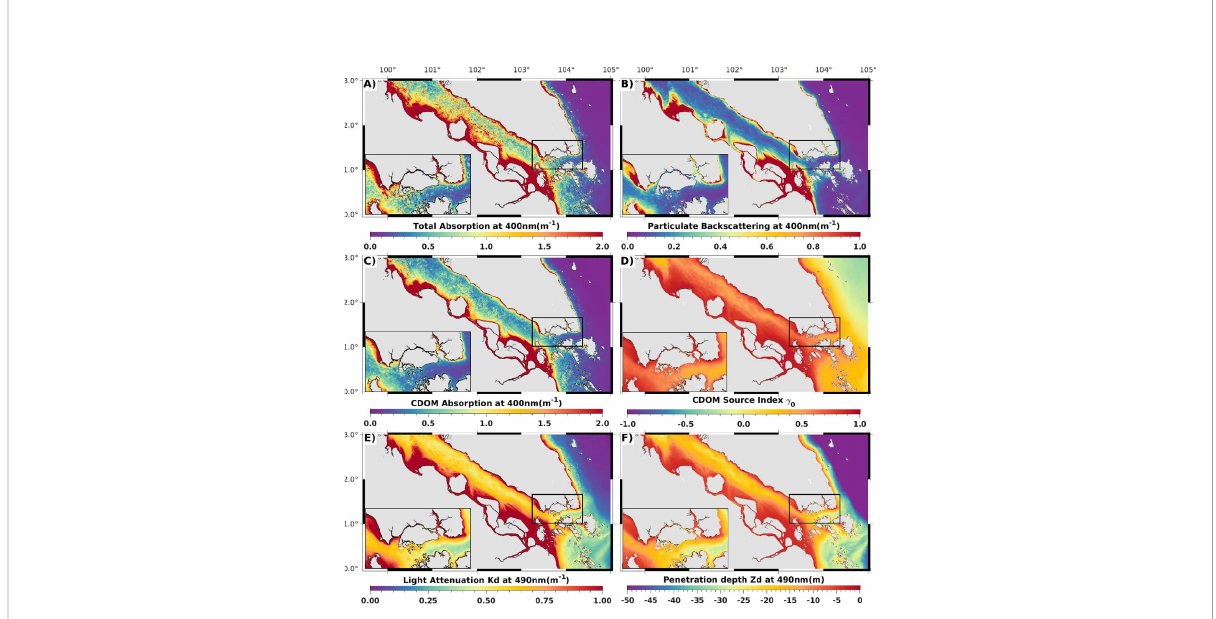
FIGURE 4 Spatial distribution of the 2017 – 2020 mean values of blended QAA derived optical properties (A) Total absorption coef fi cient of light (a t ) at 400 nm. (B) Particulate backscattering (b bp ) at 400nm. (C) CDOM absorption coef fi cient (a g ) at 400 nm. (D) CDOM source index, g 0 (values ≥ 0.5 indicate the increasing dominance of terrigenous origin of CDOM over marine) (E) Diffuse attenuation coef fi cient of light (K d ) at 490 nm. (F) Depth of penetration of light at 490 nm (Z d , 1% of the surface value). The black box corresponding to the Singapore Strait area is shown in the left corner of each